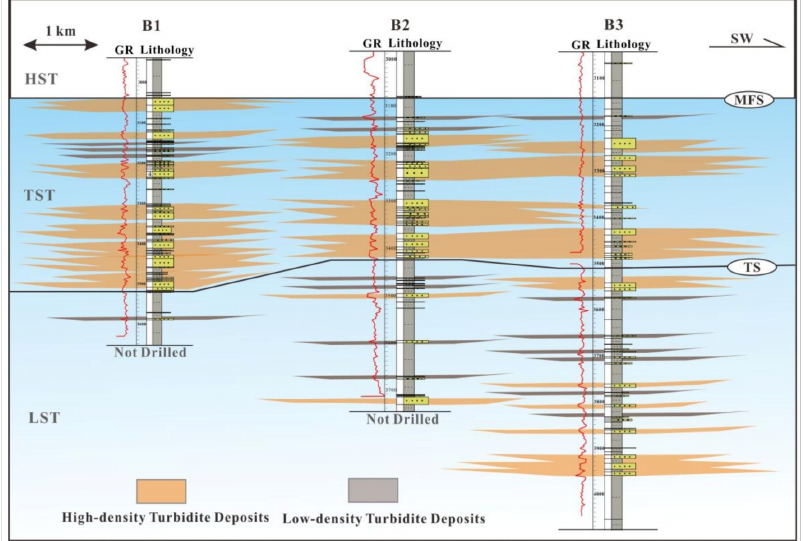
Figure 16. Well connection diagram of region B. Sublacustrine fans are mainly developed in TST. Figure 1C shows